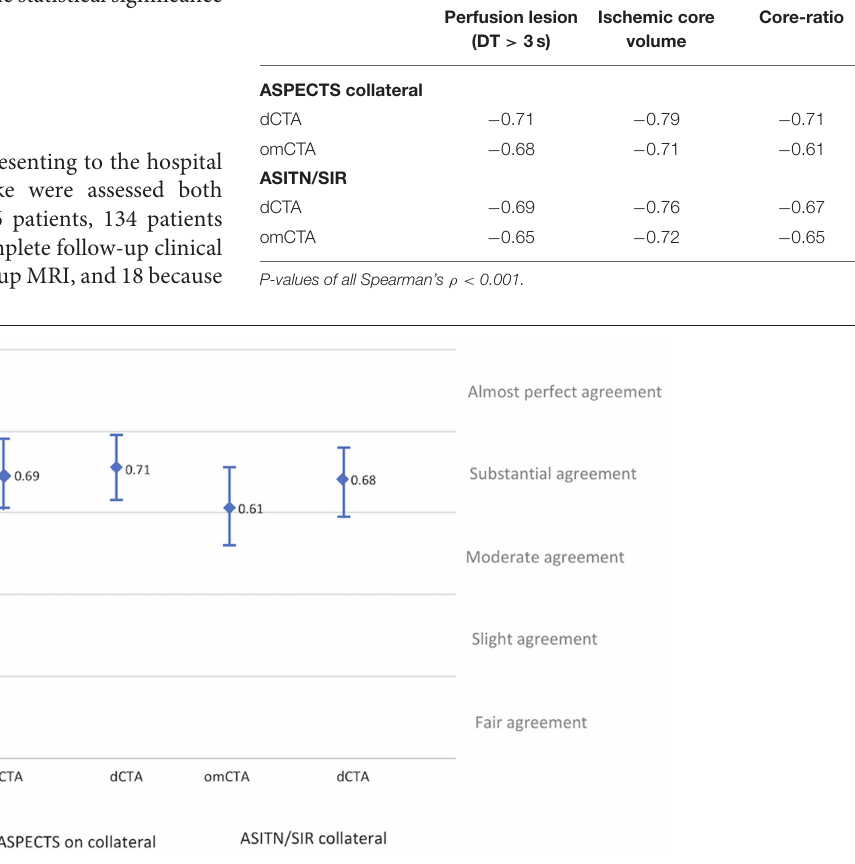
FIGURE 2 | Inter-rater reliability. Inter-rater reliability of the four raters after training for each angiographic imaging modality and collateral grading systems.